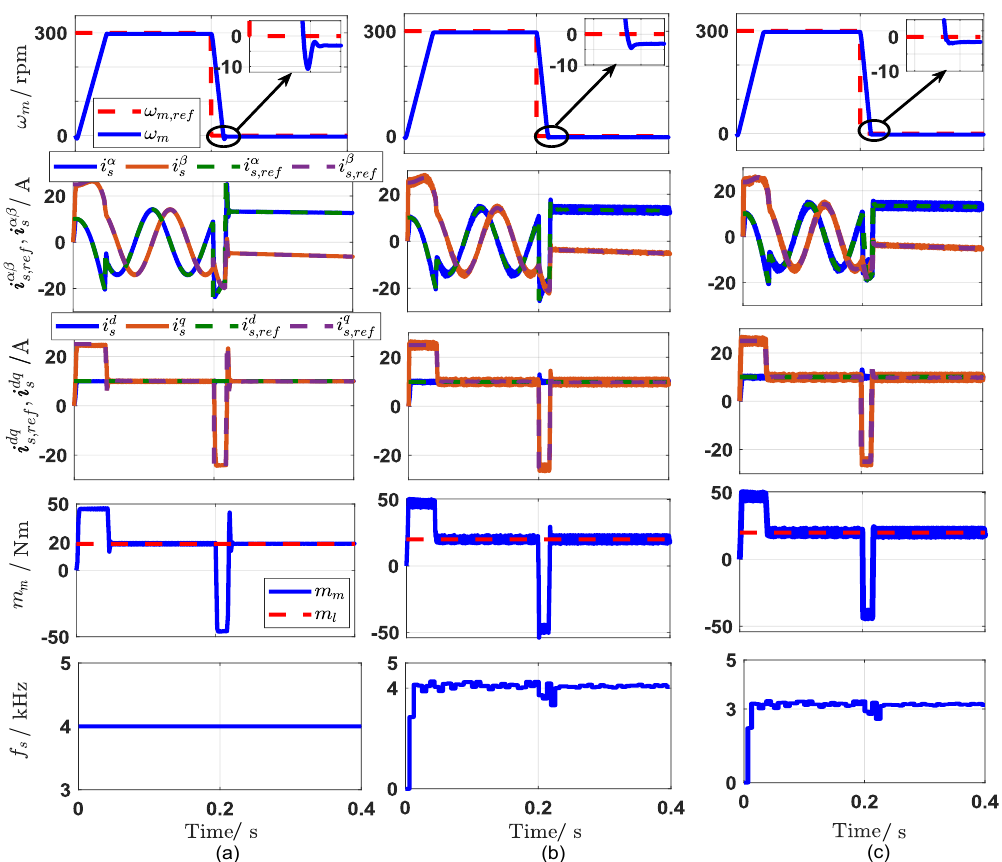
Figure 14. Dynamic performance of the different control strategies under a step change of rotor mechanical speed form 300 rpm to mechanically stopped: ( a ) FOC, ( b ) CPC, and ( c ) Proposed